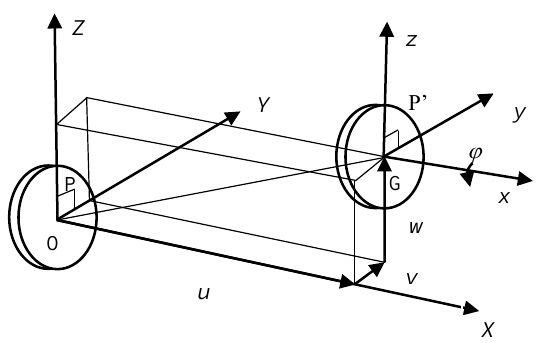
Figure 1. Coordinate systems and geometry of rotating bar. Based on Euler Bernoulli beam theory which does not consider transvers shear, the linear strain- displacement relationship can be expressed as